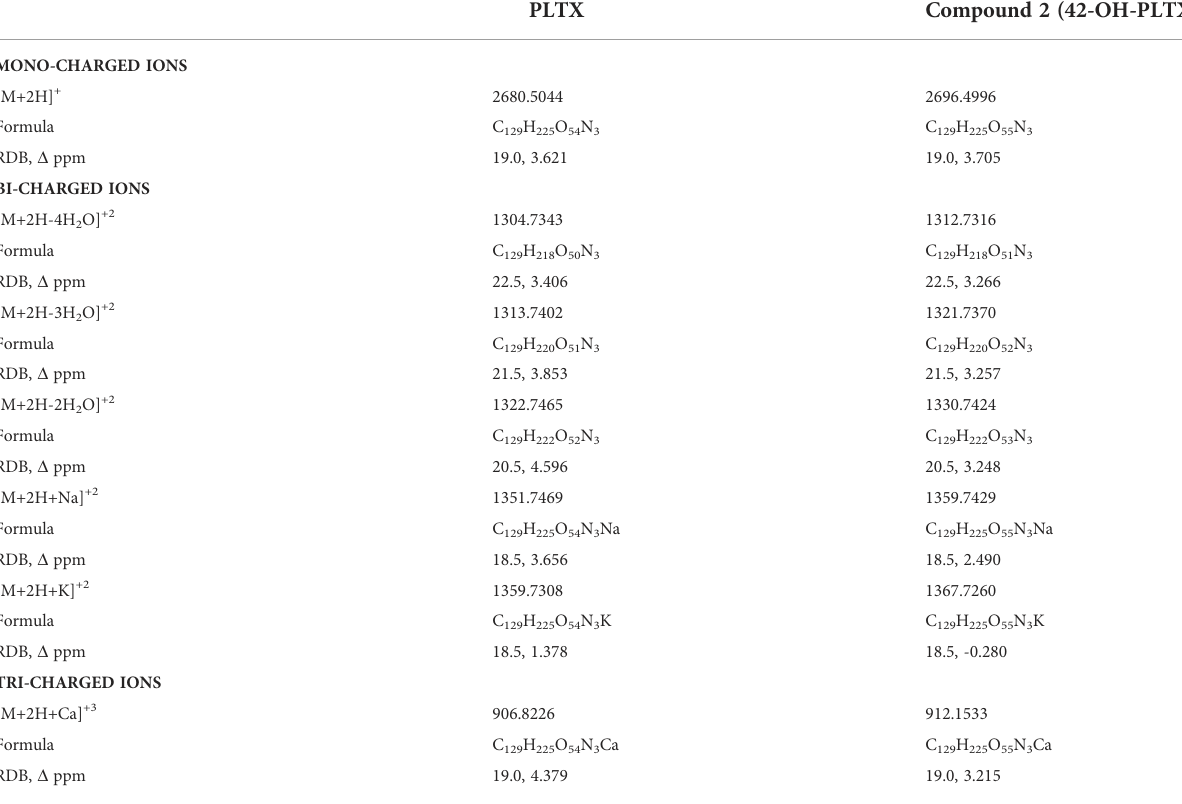
TABLE 1 HRMS data of PLTX and PLTX-like compound 2 (42-OH-PLTX) obtained from full MS spectra acquired in the mass ranges m/z 2000- 3000, m/z 1200-1400 and m/z 850-950.